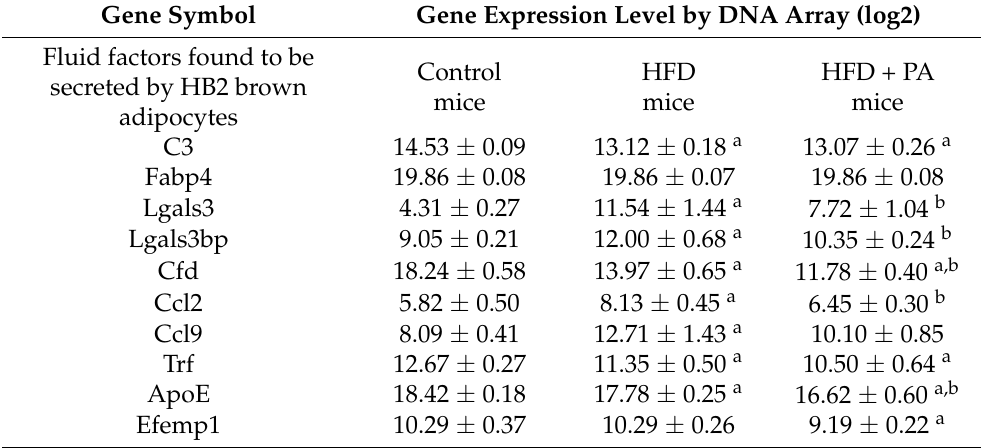
Table 3. Expression levels of mRNA for representative humoral factors in the interscapular BAT of control, HFD, and HFD + PA